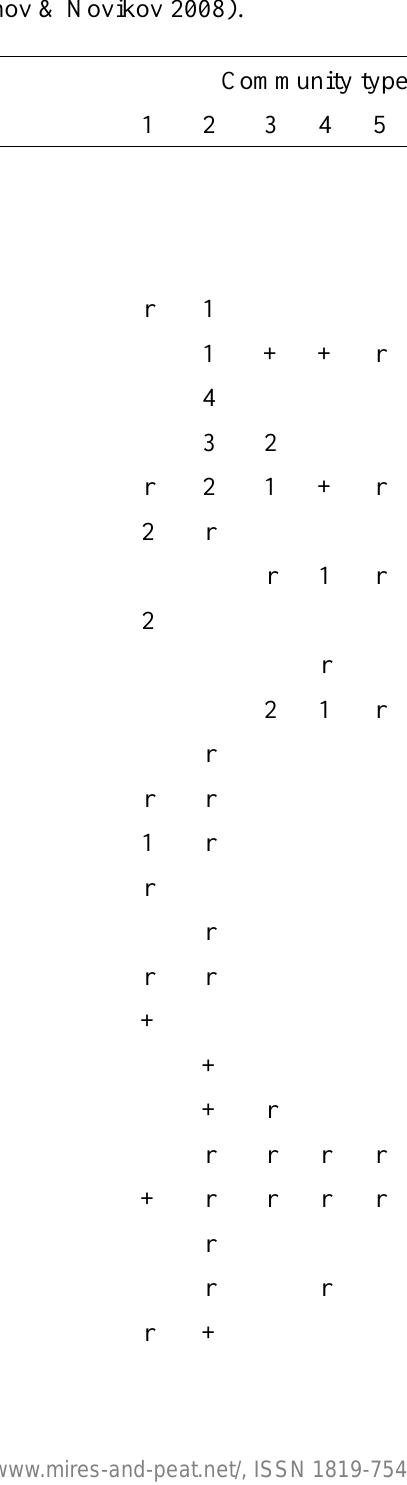
Table A1. Floristic composition of the different types of plant communities in the Natural Monument “Arkaulovskoye Mire”, Republic of Bashkortostan, Russia. Types: 1 = periodically flooded grey alder - bird cherry forest, 2 = sedge - reed birch and birch - alder forested mire, 3 = sparse pine and birch forested mire, 4 = moss - shrub dwarf pine forested mire, 5 = Schoenus ferrugineus - small sedges - brown mosses open mire, 6 = vegetation of pools, 6a = vegetation of streams. The indices in Columns 1–7 are average Braun-Blanquet cover-abundance scores calculated for each species per community type. Asterisks (*) indicate species that are included in the Red Data Book of Bashkortostan (Mirkin 2011), and double asterisks (**) are species that are listed in the Red Data Book of the Russian Federation (Bardunov & Novikov